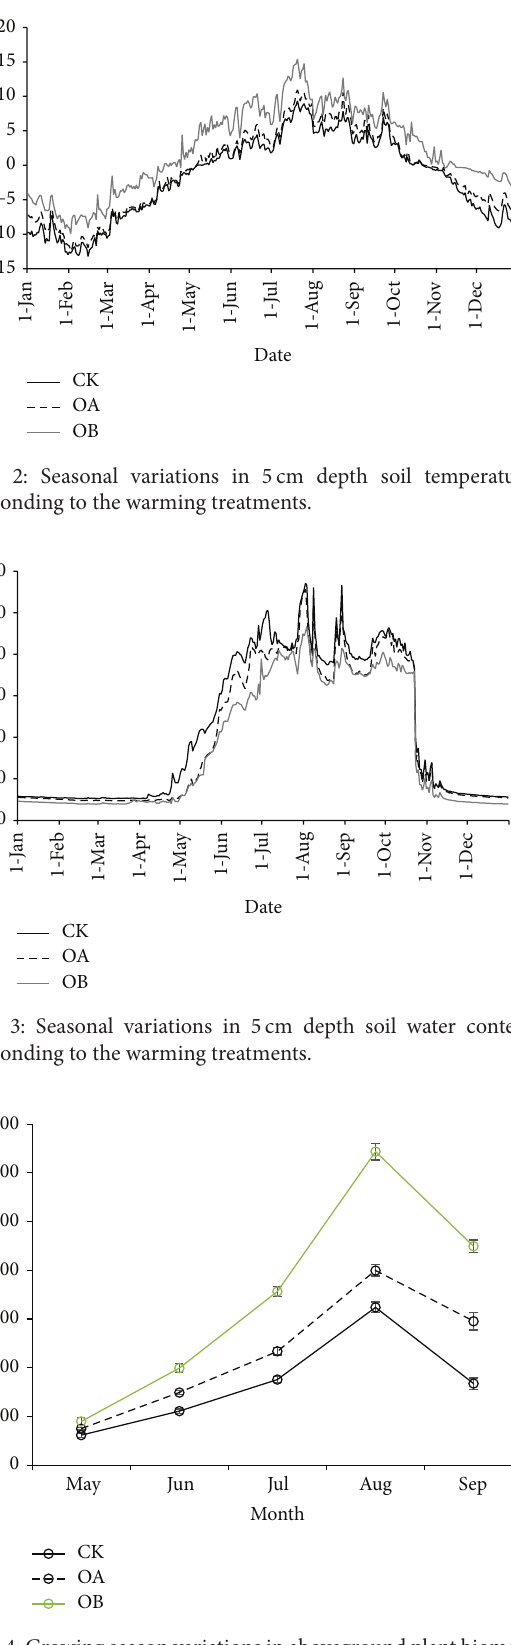
Figure 4: Growing season variations in aboveground plant biomass corresponding to the warming treatments.